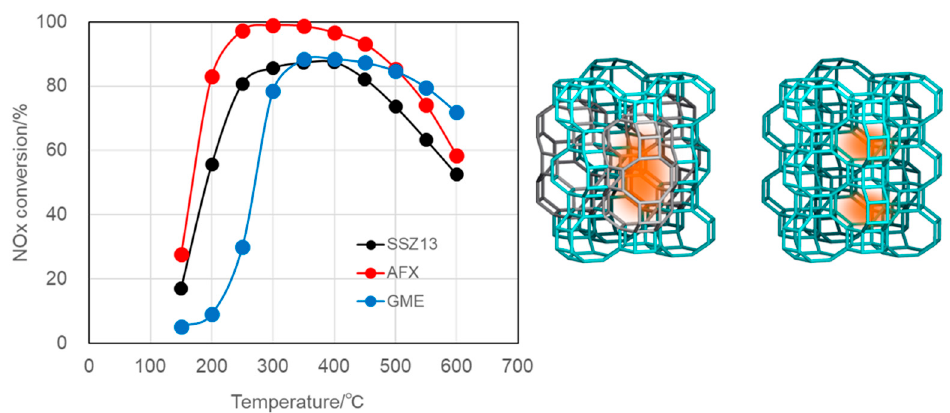
Figure 8. Catalytic performances of AFX and GME zeolites compared with other candidates for NH 3 -SCR. Frameworks of AFX ( middle ) and GME ( right ) are illustrated.